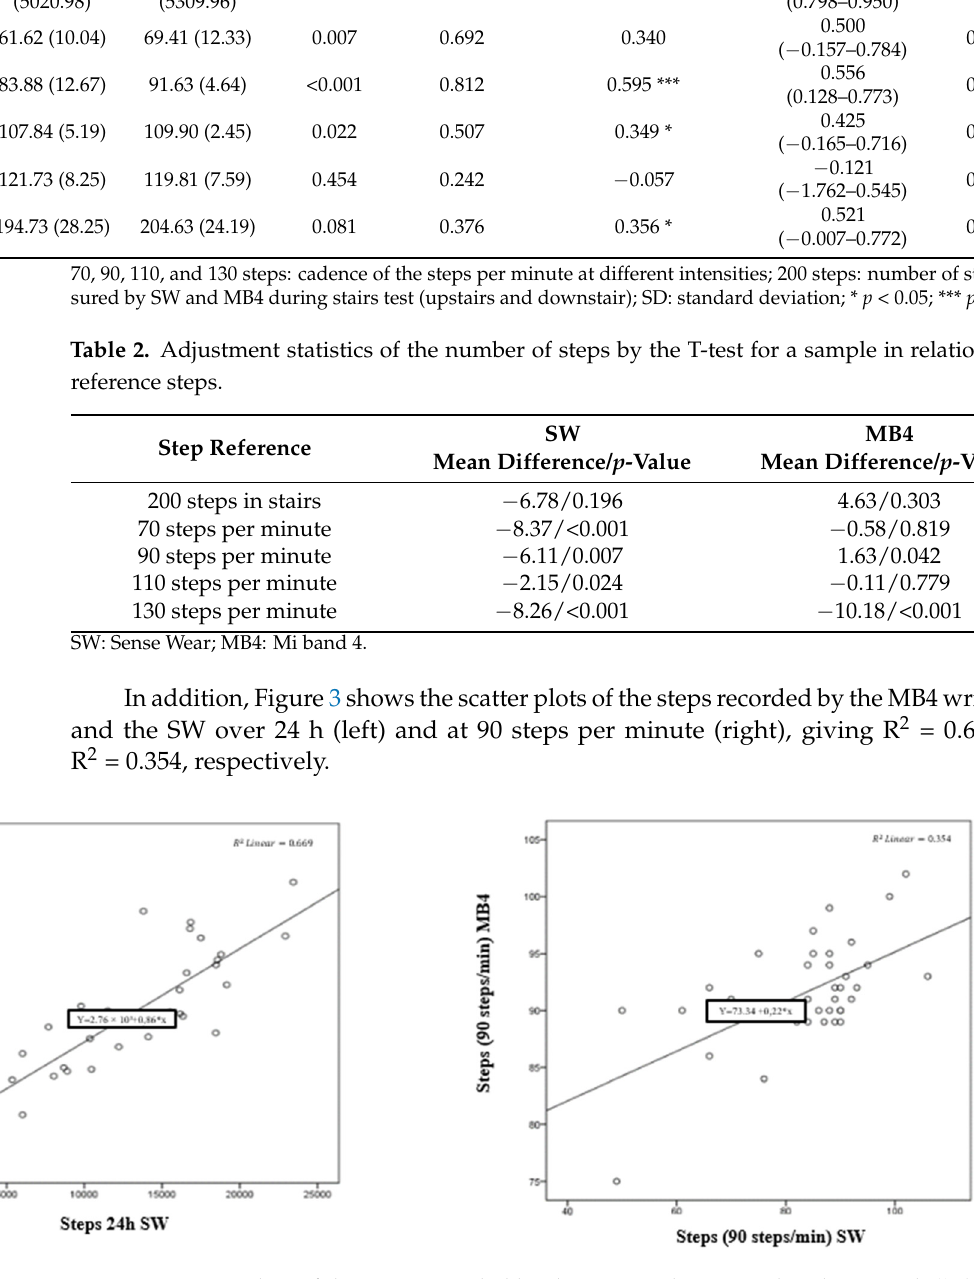
Figure 4. Number of steps obtained in comfortable and fast gait by MB4 and the target count by video. Bland-Altman plots in the process of calculating the concordance between MB4 and SW in the different protocols are showed in Figure 5.